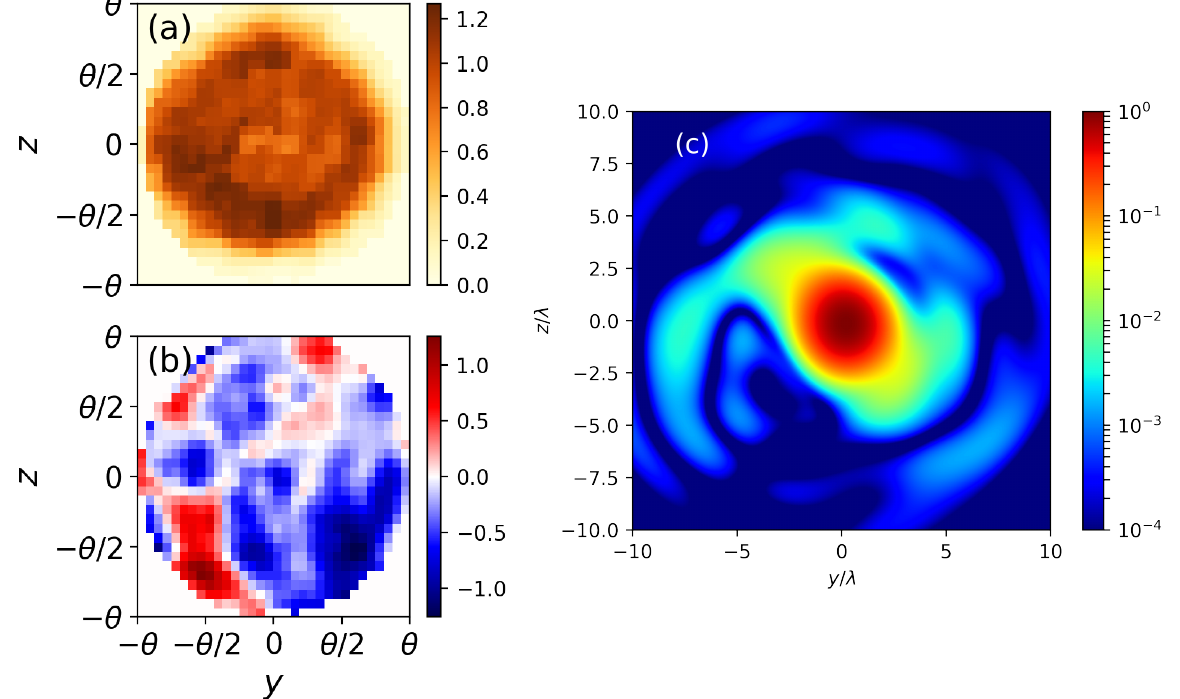
Figure 8. Example of focal spot calculated from realistic profile: ( a ) typical transverse intensity profile (a. u.) and ( b ) wavefront (in radians) without correction of extra aberrations during beam transport from the end of the laser to the experiment and ( c ) normalized focal intensity obtained applying our method with a f-number f =